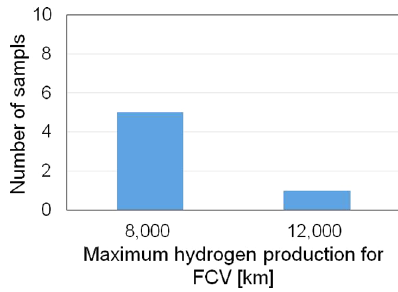
Fig. 9. Distribution of maximum hydrogen production (two households).